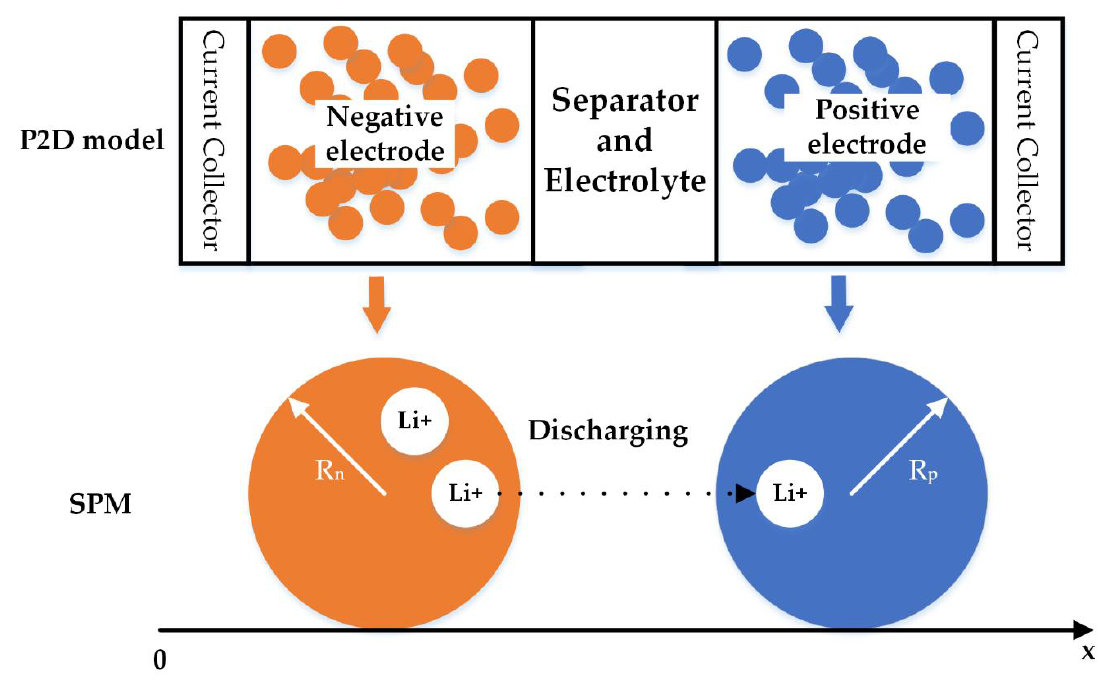
Figure 2. Structure of the pseudo-2D (P2D) model and SPM. Reproduced from [55]. Copyright 2017, Electrochemical Society.